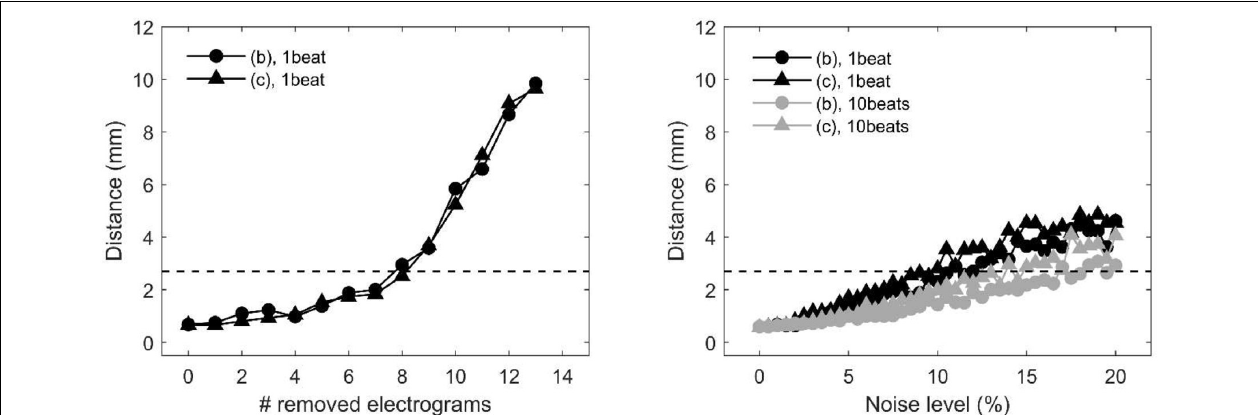
FIGURE 4 | Effects of missing or corrupted data on the accuracy of localization of focal drivers by divergence analysis in a tissue patch with homogeneous (pattern b) and heterogeneous conduction properties (pattern c) in the presence of partially corrupted data. Distance between exact and estimated focal driver position as a function of the progressive removal of electrograms (left) and at increasing levels of noise in activation time series (right). The horizontal dotted line indicates the threshold for accurate localization. In the right panel, black and gray lines correspond to single-beat and 10-beat position estimation, respectively. Data are median over 100 stochastic